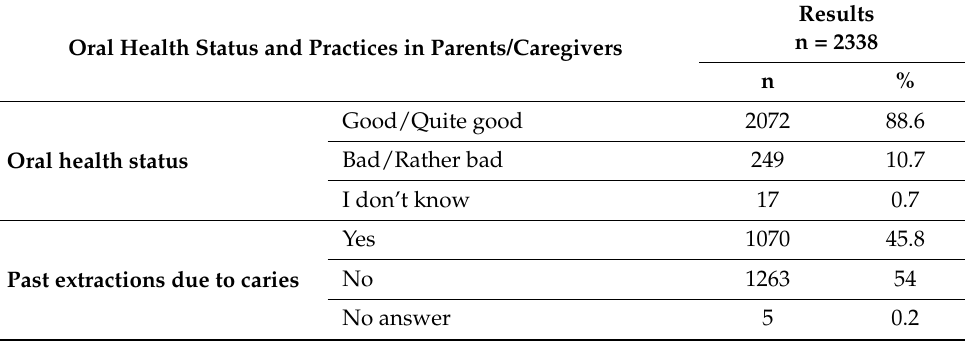
Table 4. Reported oral health status and practices in